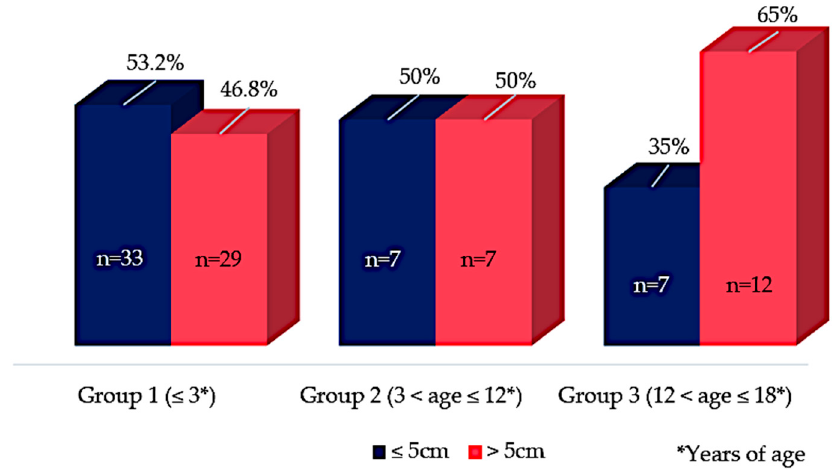
Table 4. Percental of the different staging of patients with PACTs divided in three different age ‐ groups. Figure 3. Tumor size and their relative frequencies (%) in each age-group ( n = number of cases);